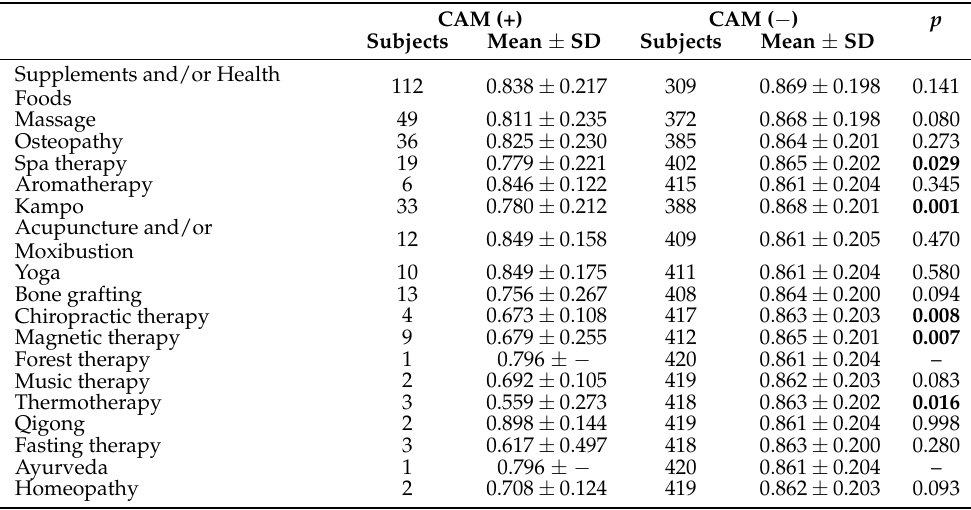
Table 3. Comparison of health-related quality of life in type 2 diabetes mellitus patients with and without the use of CAM.